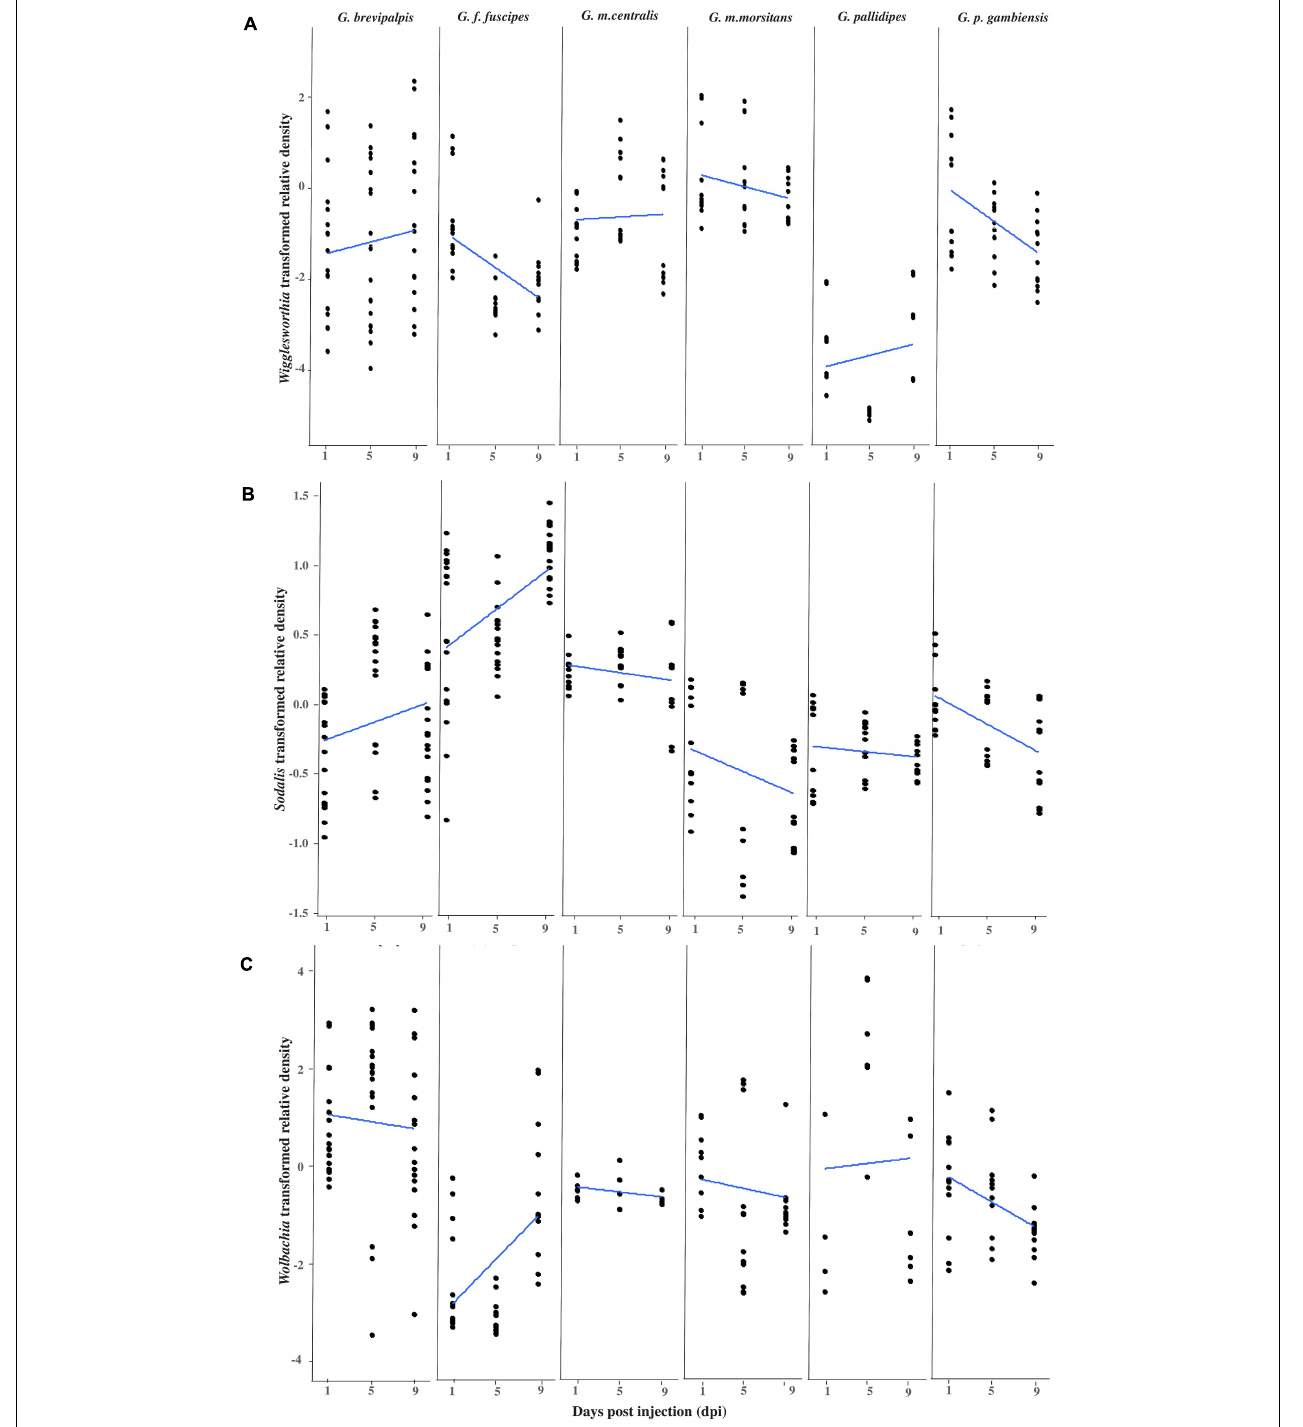
FIGURE 1 | Impact of GpSGHV infection on the density of tsetse symbionts. Transformed Wigglesworthia (A) , Sodalis (B) , and Wolbachia (C) densities for six taxa of tsetse flies injected with GpSGHV normalized against control flies. Total DNA was extracted from six females and two males at 1, 5, and 9 days post injection and used as template for qPCR. Data were normalized to the housekeeping β -tubulin gene, against time zero and against the control injected flies at each time point and transformed based on the Box-Cox lambda value. The linear regression line was calculated using the lm method in R.